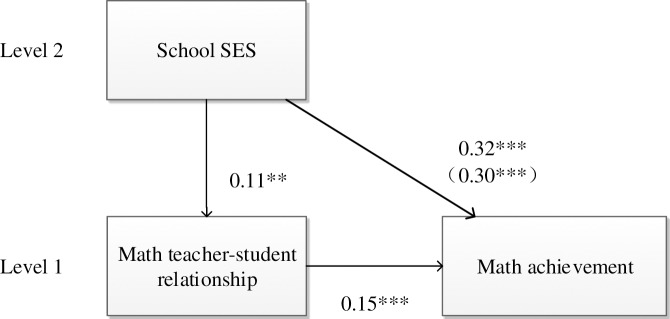
Mediation model for math.